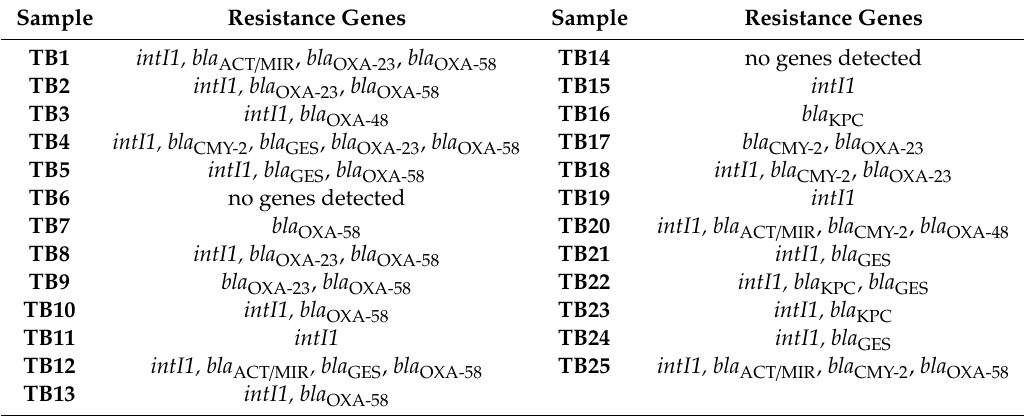
Table 6. Overview of resistance genes detected in toothbrush (TB) samples. IntI1 and bla genes are listed in descending order of the absolute abundance in gene copies mL − 1 .